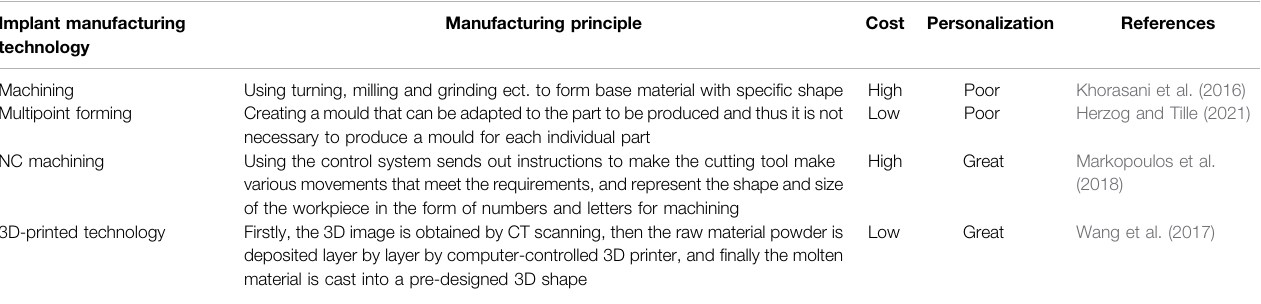
TABLE 1 | Summary of different implant manufacturing technologies, manufacturing principle, cost and